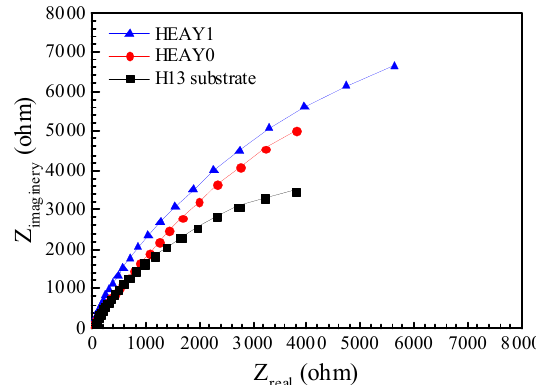
Figure 8. The electrochemical impedance measurements as Nyquist plots obtained for the substrate and laser cladded specimens in 3.5% NaCl solution.